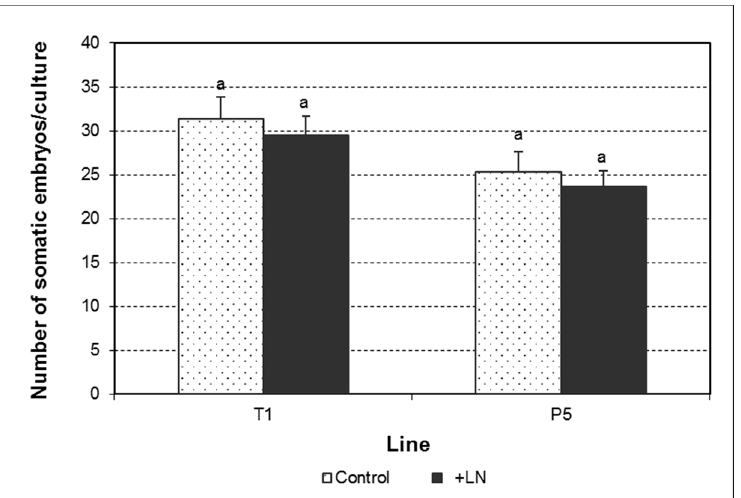
Figure 6. Number of somatic embryos developed per culture during the maturation phase from control and cryopreserved embryogenic cultures of the lines T1 and P5. Data assessed eight weeks after initiation in maturation conditions. Data represent the mean ± SEM. Different letters indicate significant differences by the LSD test with a significance level of 0.05.